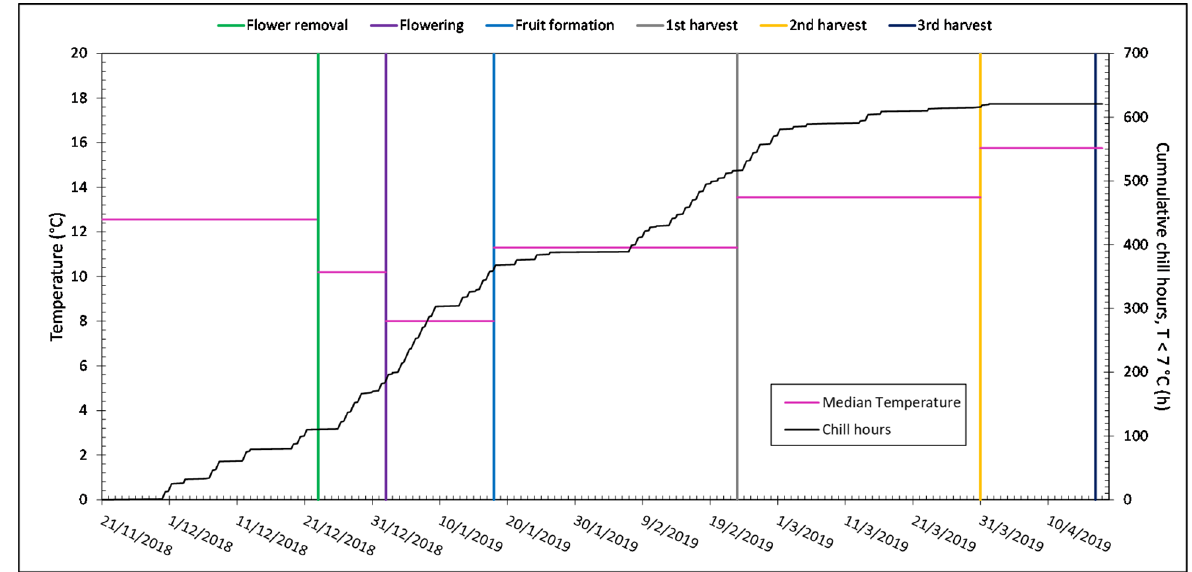
Figure 1. Cumulative chill hours and temperature data versus experiment stages.